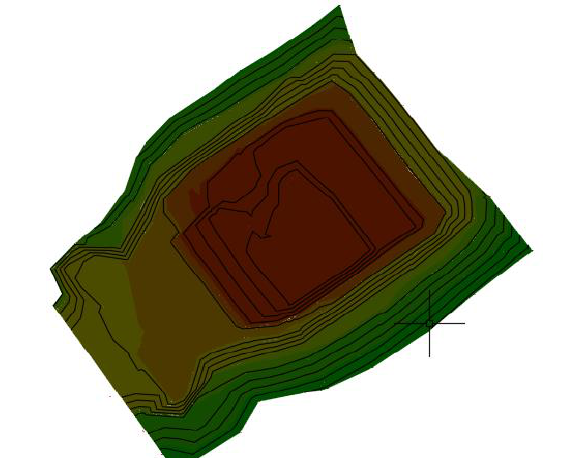
Figure 7. Land survey Reconstructed digital elevation model with 2.5 contour line Civil 3D